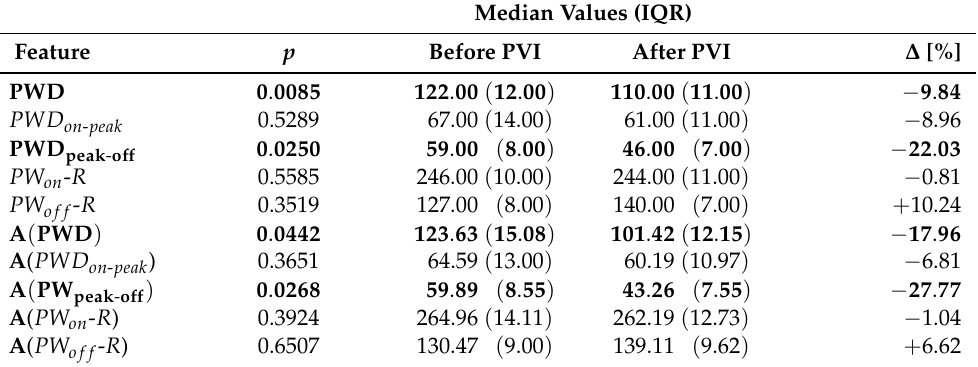
Table 1. Statistical analysis for P-wave features before and after PVI. Median values, interquartile range (IQR) and variation due to PVI. Features with statistically significant differences due to PVI are shown in bold